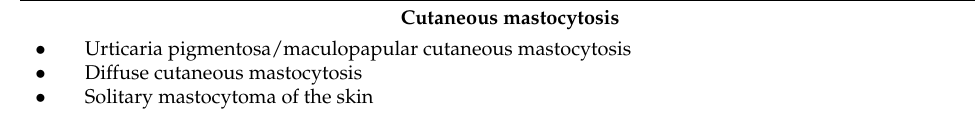
Table 1. Classification of